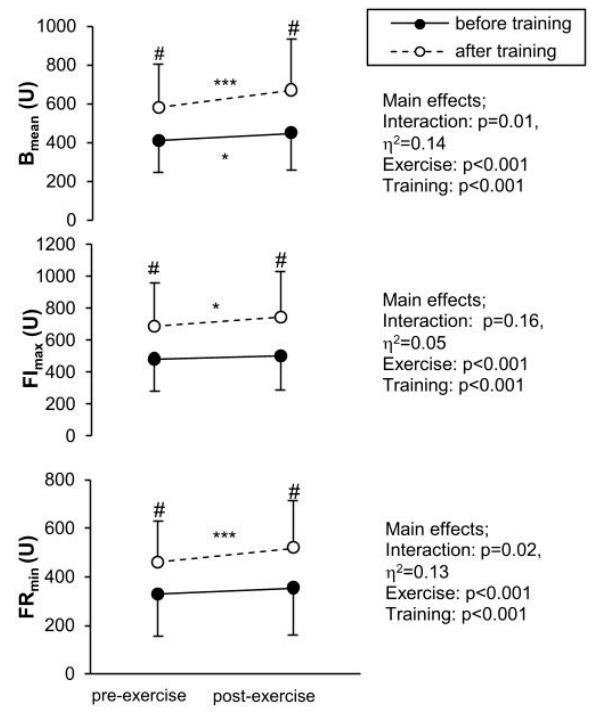
Figure 3. Measured parameters. Flow Mediated Skin Fluorescence parameters in athletes (N = 41) in two examinations, before and after the cardiopulmonary exercise test until exhaustion. B mean —Changes in the mean value of the basal fluorescence; FI max —Changes in maximal fluorescence during ischemia; FR min —Changes in the first minimal fluorescence value during reperfusion. Values are means (SD). A two-way analysis of variance (relation between exercise and training), post-hoc Scheffe test, significant differences between pre- and post-exercise: *** p < 0.001, ** p < 0.01, * p < 0.05; significant differences between before and after training # p < 0.001, ‡ p < 0.01, § p < 0.05.